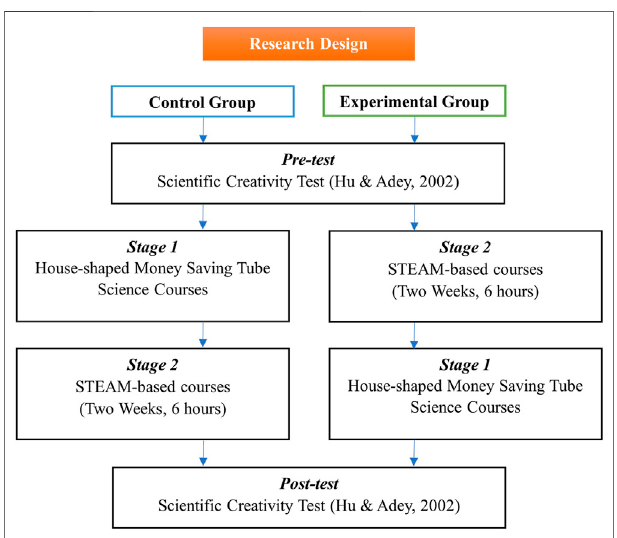
FIGURE 3 | The research design structure of this